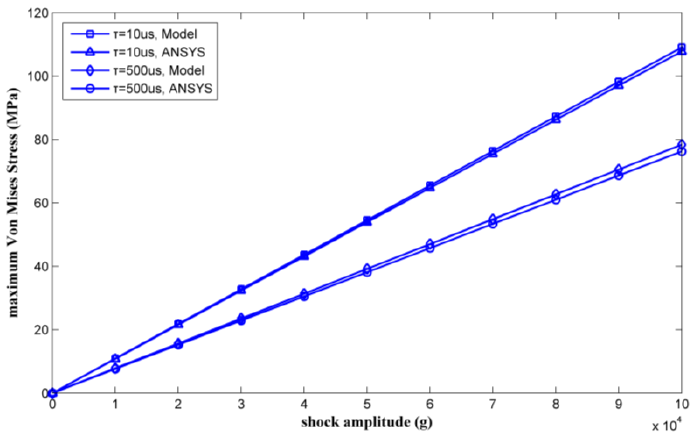
Figure 15. Maximum Von Mises equivalent stress as calculated by ANSYS and the proposed model versus shock load amplitude.